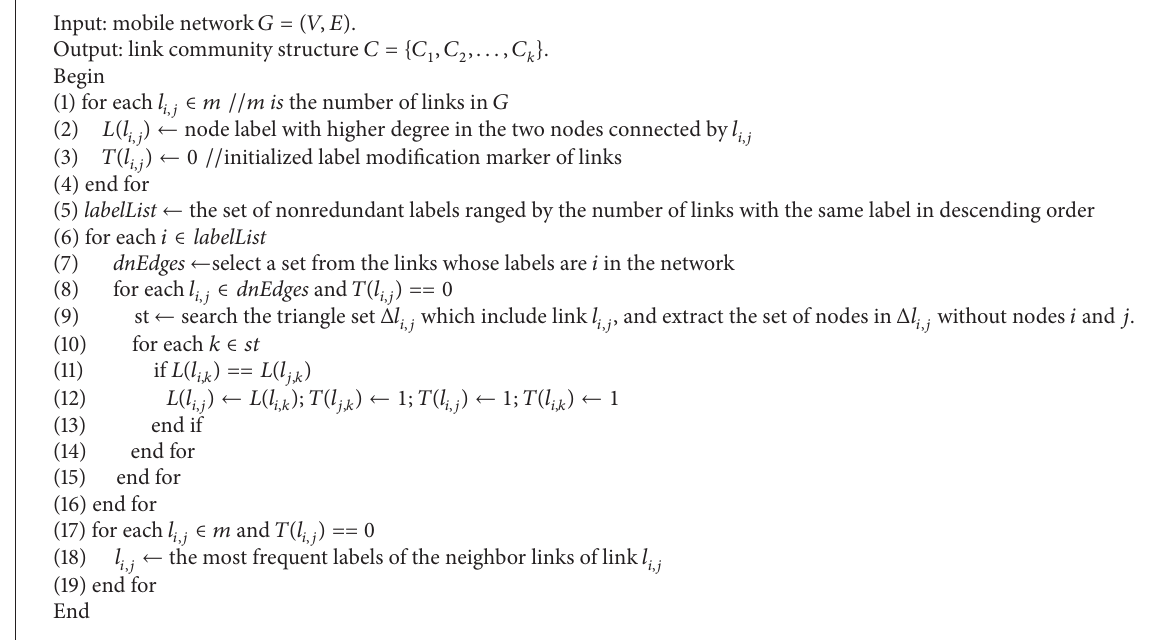
Algorithm 1: Link label diffusion algorithm (LLDA).